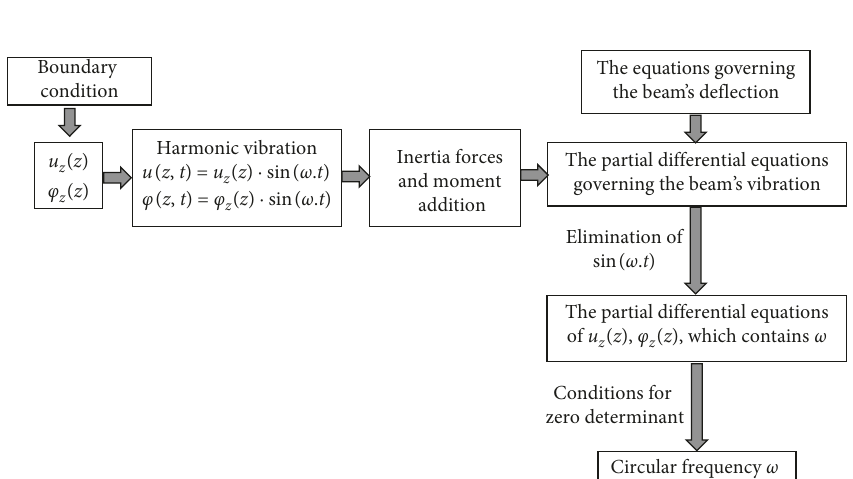
Figure 2: Flowchart to determine the free vibration frequencies by Approach